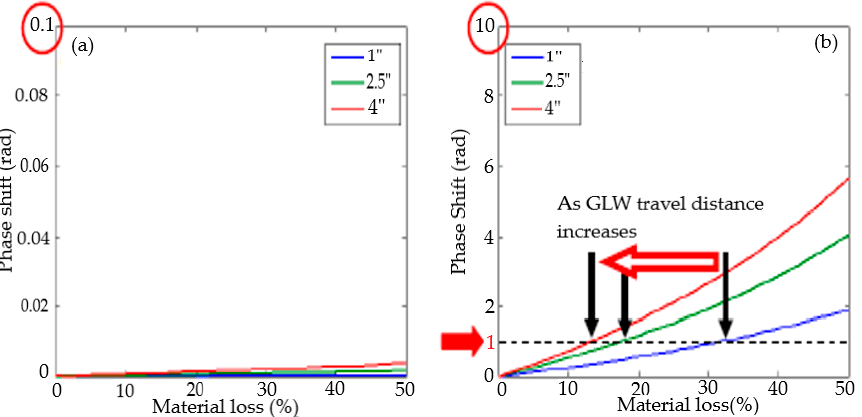
Figure 10. Phase shift estimation according to three-wave propagation distance (60 kHz excitation) ( a ) S0 mode ( b ) A0 mode of GLWAdpted with permission from [59]. Copyright 2012, ASME.